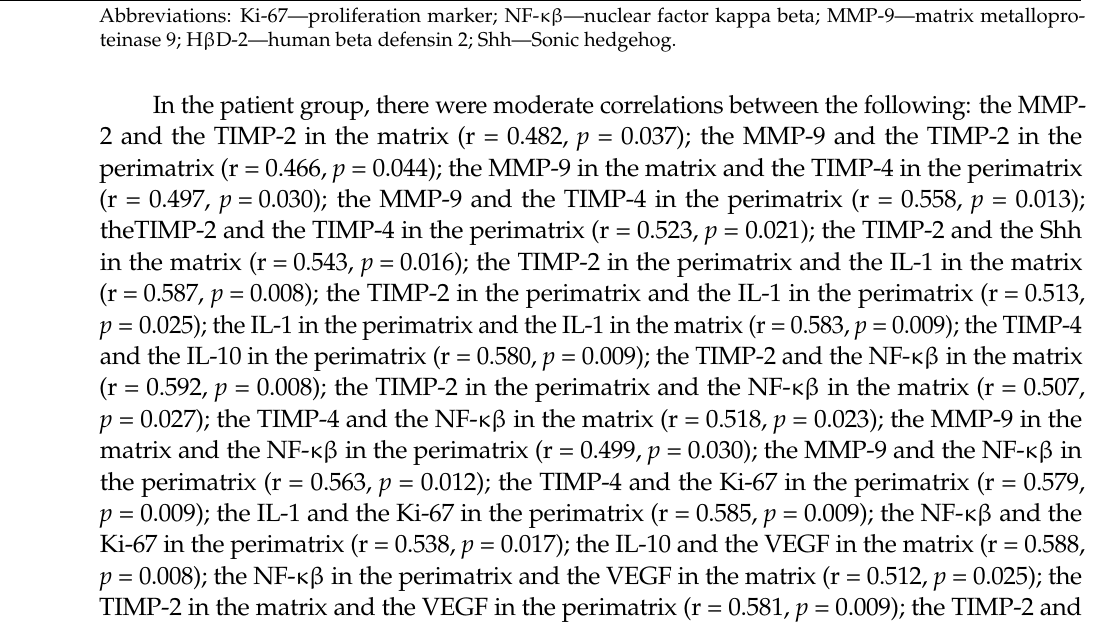
Figure 8. ( a , b ) Immunohistochemical micrographs. ( a ) Cholesteatoma . Numerous Shh - positive cells in the matrix and a moderate number in the perimatrix, Shh IHC. ( b ) Skin . Numerous-to-abundant